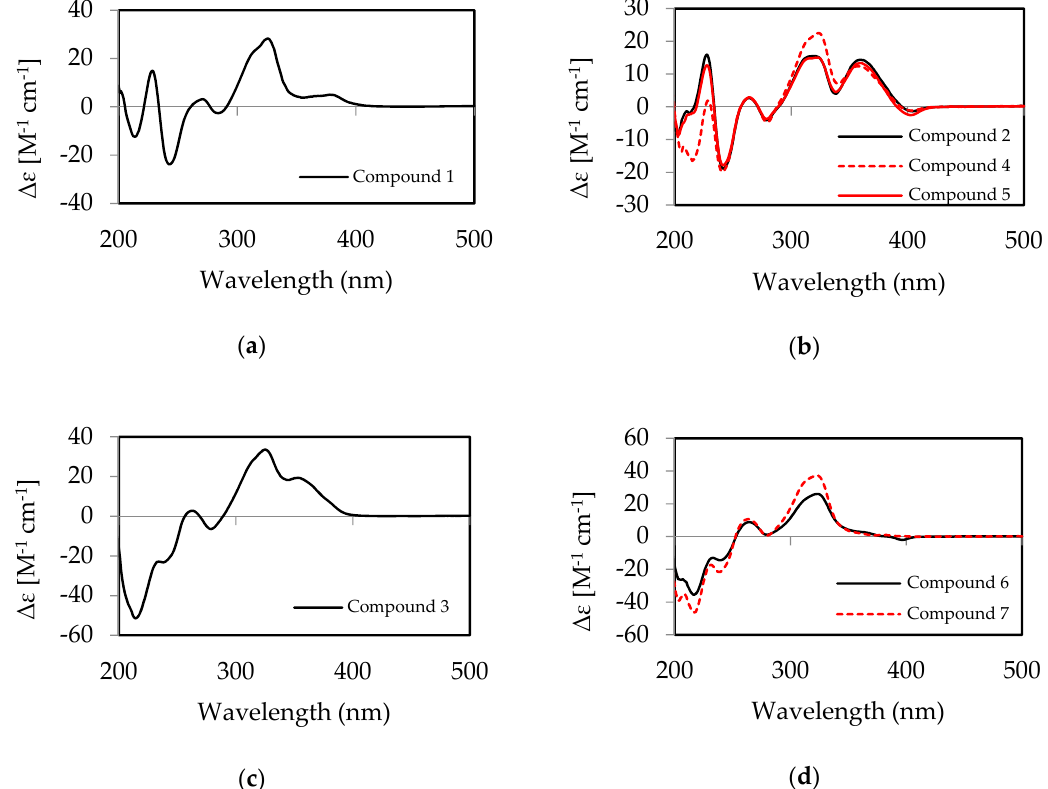
Figure 2. Electronic Circular Dichroism (ECD) spectra of compounds 1 – 7 measured in MeOH, ( a ) ECD spectrum of 1 (2 S , 3 S , 1 ′ S , 11 ′ S , and 14 ′ R ), ( b ) ECD spectra of 2 (2 S , 3 S , 1 ′ S , 11 ′ S , and 14 ′ R ), 4 (2 S , 3 S , 5 S , 1 ′ S , 11 ′ S , and 14 ′ R ), and 5 (2 S , 3 S , 1 ′ S , 11 ′ S , and 14 ′ R ), ( c ) ECD spectrum of 3 (2 R , 3 S , 1 ′ S , 11 ′ S , and 14 ′ R ), ( d ) ECD spectra of 6 (2 R , 3 S , 1 ′ S , 11 ′ S , and 14 ′ R ) and 7 (2 R , 3 S , 1 ′ S , 11 ′ S , and 14 ′ R ).